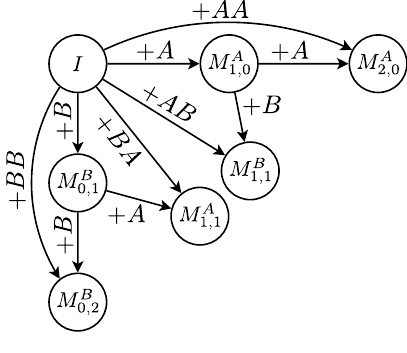
Figure 1. All possible transitions for copolymer chain lengths ≤ 2. For example, the transition from the initiator state I to the state M A (copolymer chains having two A -monomers and ending in A ) 2,0 corresponds to adding the sequence AA . Note that transitions that add more than two monomers correspond to multiple events. For example, the transition of I to M A corresponds to adding the two 2,1 sequences BAA and ABA